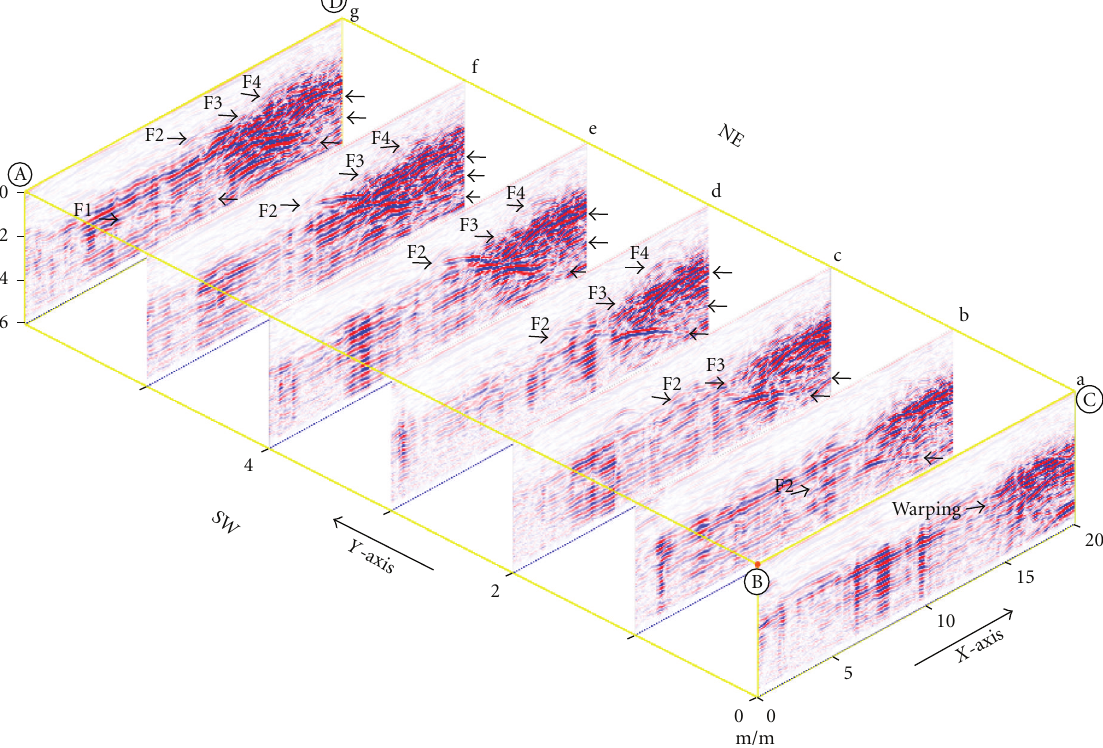
Figure 4: Sliced 3D grid profile across the HF2 scarp at Sandhwal Village collected with 200 MHz antenna (refer to Figures 2(a) and 2(b) for location). The profile was collected for a grid-ABCD with dimensions of 20 m × 6m. The dashed lines and arrowheads represent the faults. The grid was sliced along the Y -axis along the strike of the scarp at 1m interval (seven slices from a – g ). Changes in the pattern of deformation along the strike can be noticed from the slices. For location of the grid, refer to Figure